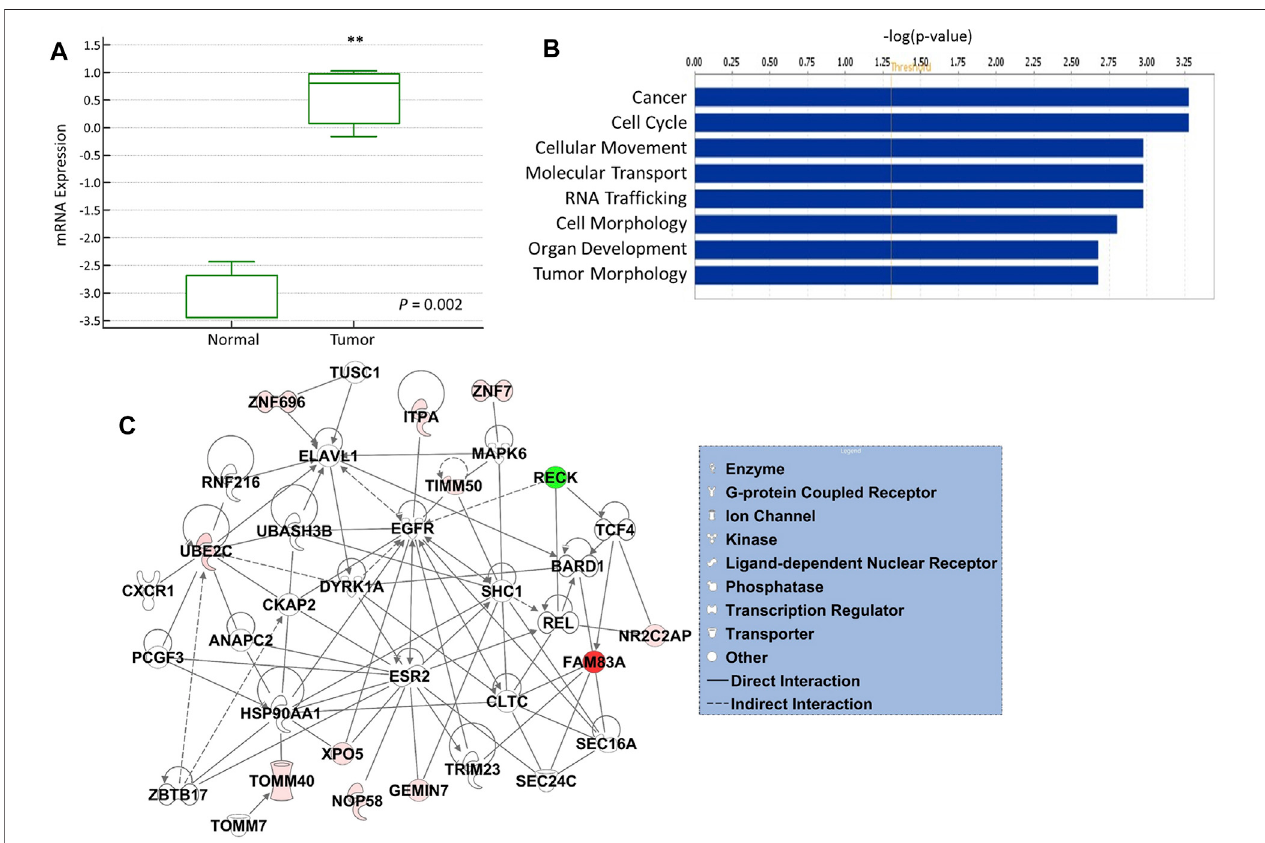
FIGURE 4 | (A) mRNA gene expression of 12-gene signature score in blood from tumor vs. normal. (B) Gene ontology and functional analysis of the 12-gene signature. X-axis represents the signi fi cance ( – log10 ( p -value)) of the functional term. p -value of 0.05 is indicated as the threshold line in the fi gure (C) Gene interaction network analyses of the 12-gene signature. Red/green indicates higher/lower expression in NSCLC compared to controls. Straight lines are for direct interactions and dashed lines for indirect ones.